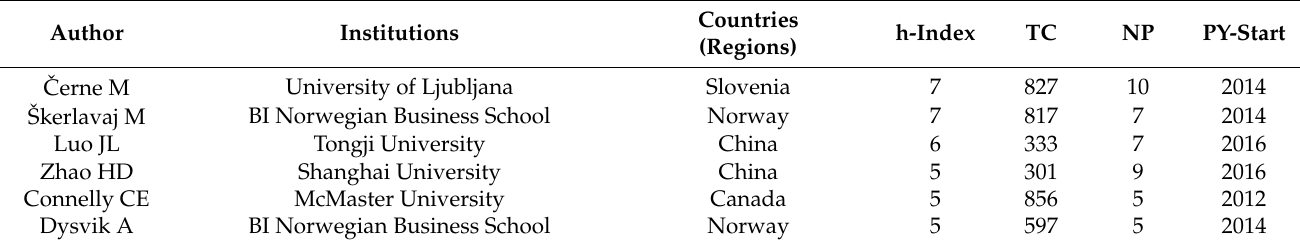
Table 3. Top 20 influential